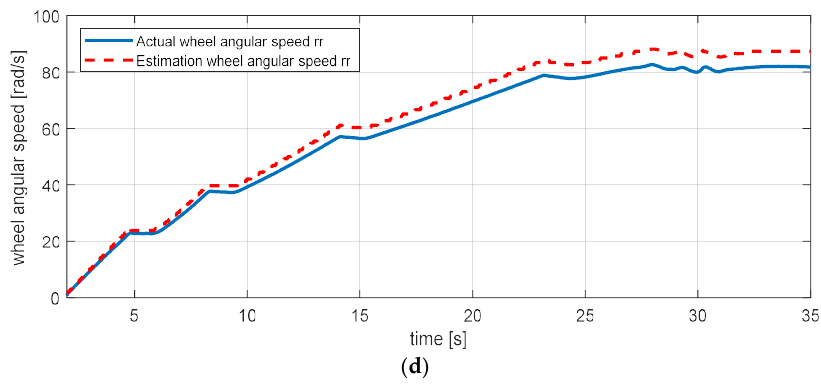
Figure 7. Estimation simulation result for wheel angular speed. ( a ) Wheel angular speed—fl (front left); ( b ) wheel angular speed—fr (front right); ( c ) wheel angular speed—rl (rear left); ( d ) wheel angular speed—rr (rear right).